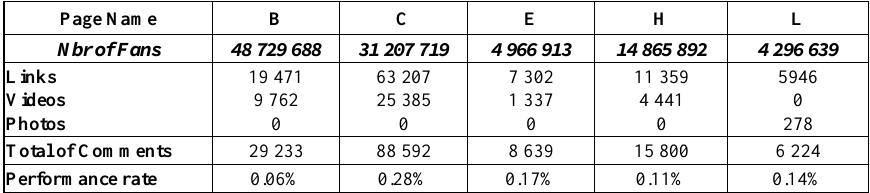
Table 2. Results Analysis of « Comments » on posts sharing in Facebook pages